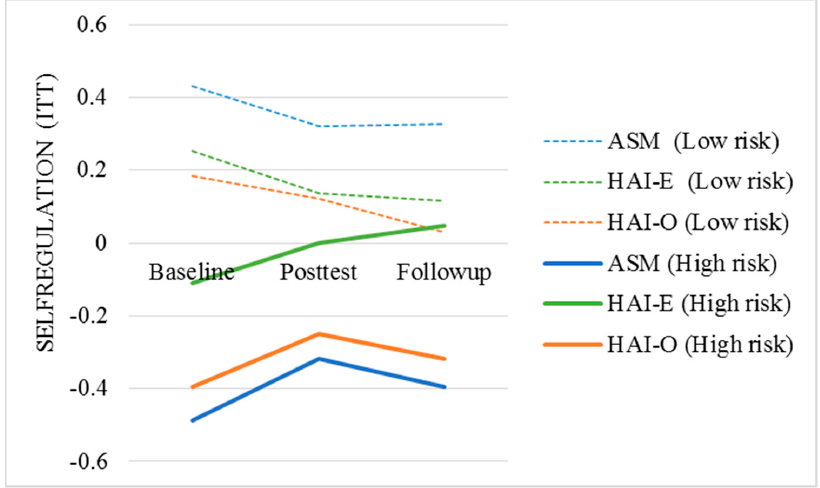
Figure 3. Trajectory of SELFREGULATION composite scores by treatment condition and risk status. ASM: Academic Stress Management; HAI-E: Human–Animal Interaction Enhanced; HAI-O: Human-Animal Interaction only; ITT: